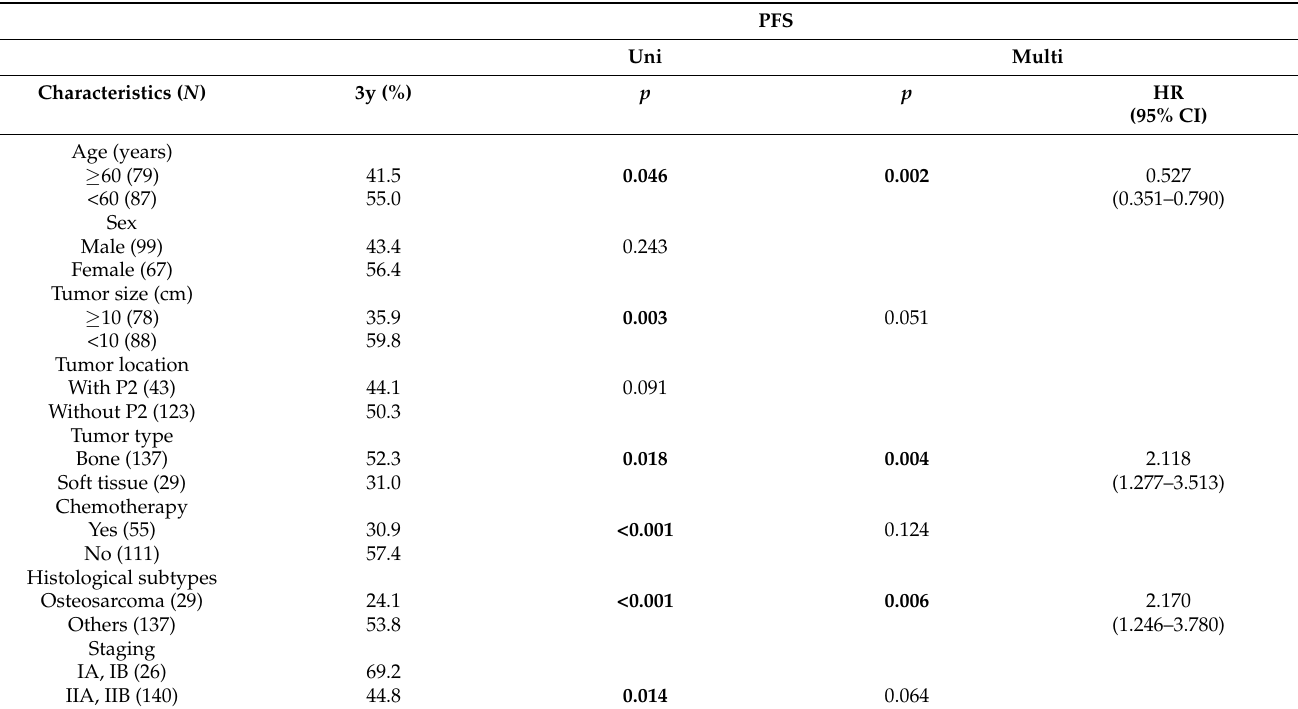
Table 5. Univariate and multivariate analyses for PFS in M0